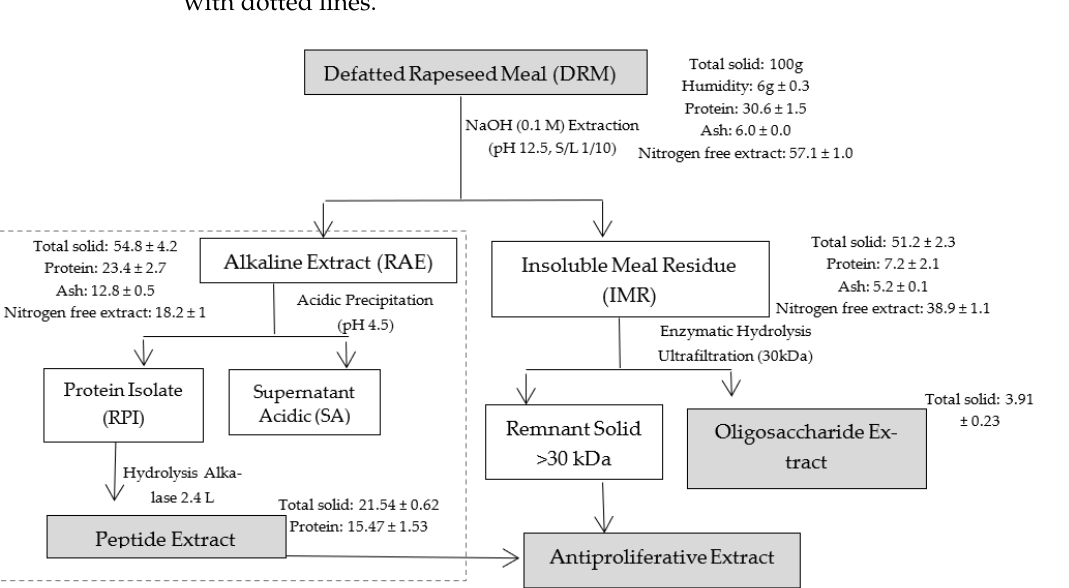
Figure 1. Workflow of antiproliferative extract extraction.